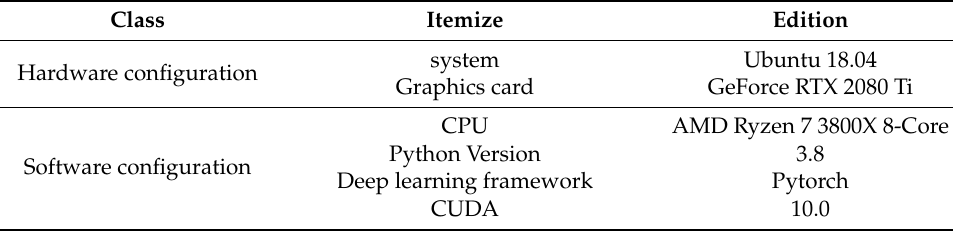
Table 1. Experiment Operating Environment (List of equipment and versions required for the experiment). Class